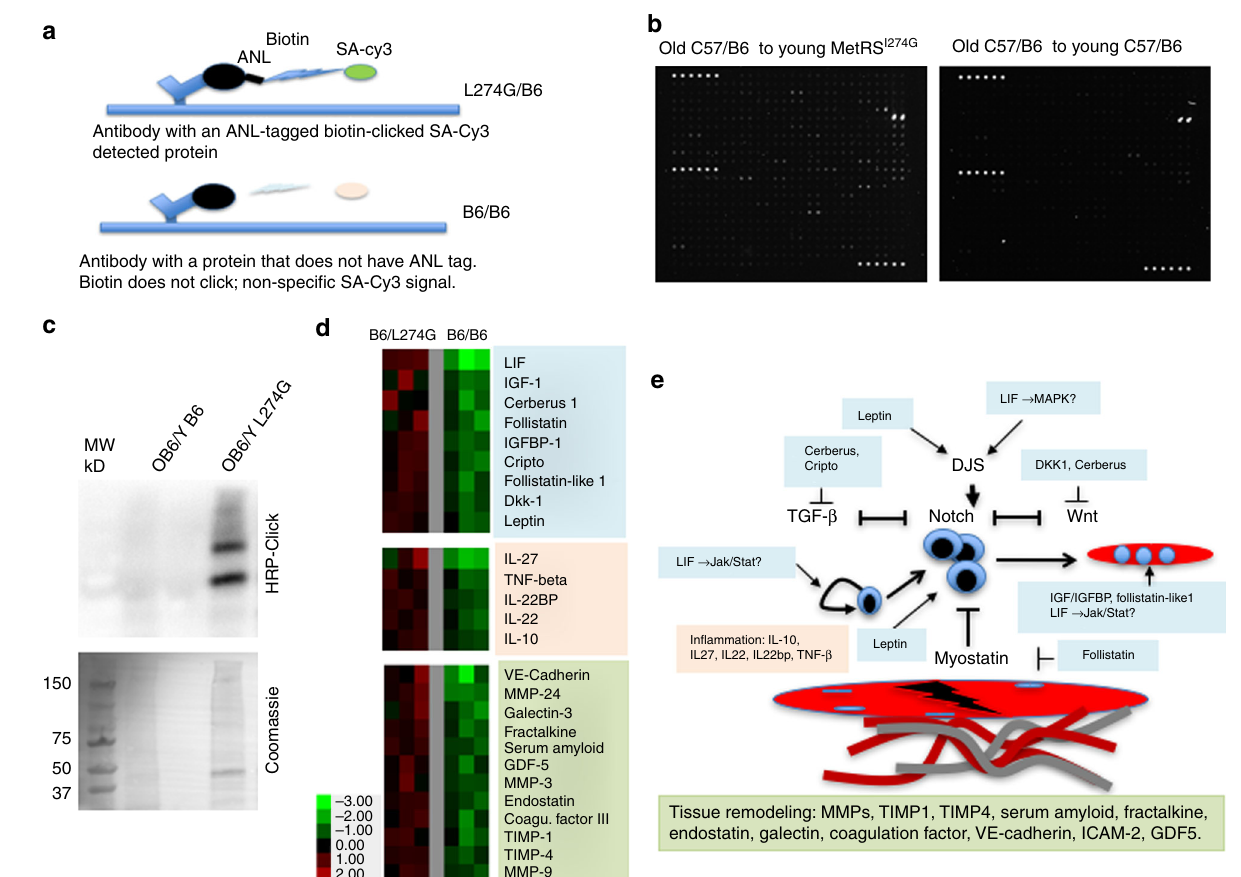
Fig. 5 Proteomics of the ANL labeled proteins that are derived from muscle of old C57BL/6 parabiotic partners of young MetRS L274G mice. a Scheme of the application of antibody arrays to BONCAT focused proteomics. b Representative images of scanned antibody arrays that were performed with the muscle lysates from old C57BL/6 animals parabiosed to young MetRS L274G partners as compared to isogenic C57BL/6 pairs. The lysates were isolated from CTX injured TA and Gastroc muscles at 3 days post injury. c For these antibody arrays a Click-western blotting was performed to con fi rm detectable ANL- labeling in the muscle lysates from old C57BL/6 to young MetRS L274G parabionts, as compared to the background noise of the syngeneic C57BL/6 parabionts. Coomassie blue staining demonstrates equal protein loading. d Heat Map of the proteins that were detected at > 2.0-fold higher levels in the muscle of old C57BL/6 mice parabiosed to young MetRS L274G , as compared to those parabiosed to young C57BL/6 animals with statistical signi fi cance of P < 0.05 (Wilcoxon rank sum test). n = 3. Color-coding: myogenic regulators ( blue ), in fl ammation regulators ( pink ), tissue remodeling proteins ( green ). e Schematic cartoon of the possible roles of the young proteins (colored boxes that correspond to protein grouping in the Heat Map) that were detected in the muscle of old parabiotic partners, grouped by canonical roles in regulating myogenic proliferation and differentiation, TGF-beta/myostatin, Notch and WNT signaling pathways, tissue remodeling and in fl ammation. Question marks signify